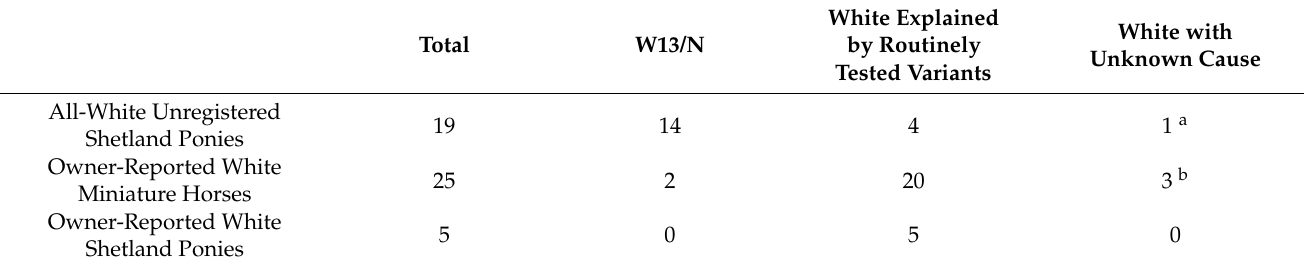
Table 1. Numbers and cause of all-white coat patterning in Miniature Horses and Shetland ponies.